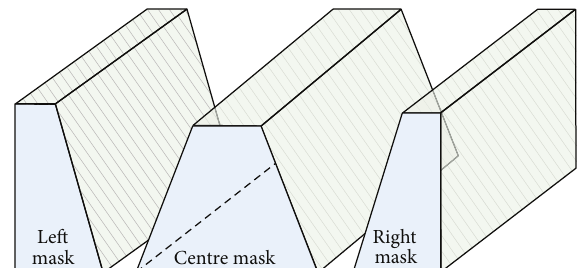
Figure 6: Image masks showing which parts of the colour and depth images are processed (in white) for a user travelling straight ahead (center mask). These white regions are termed “safe navigation regions.” The equivalent masks used to assess whether to turn to the left or right are shown to the sides of the center